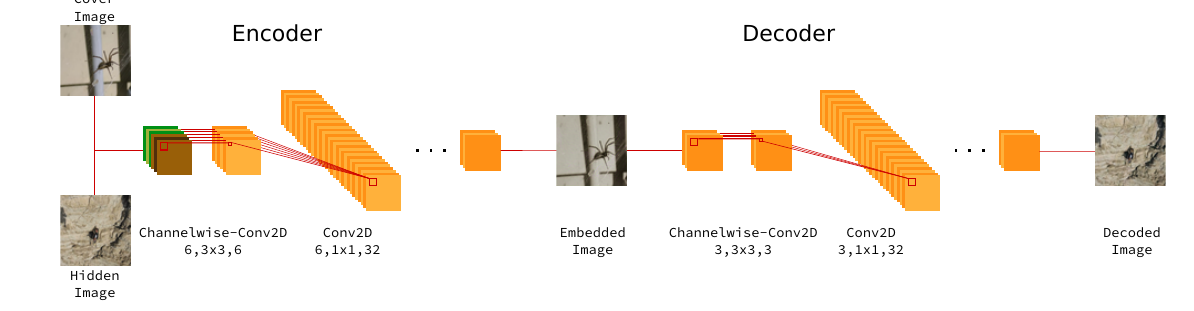
Figure 8. StegNet Processing